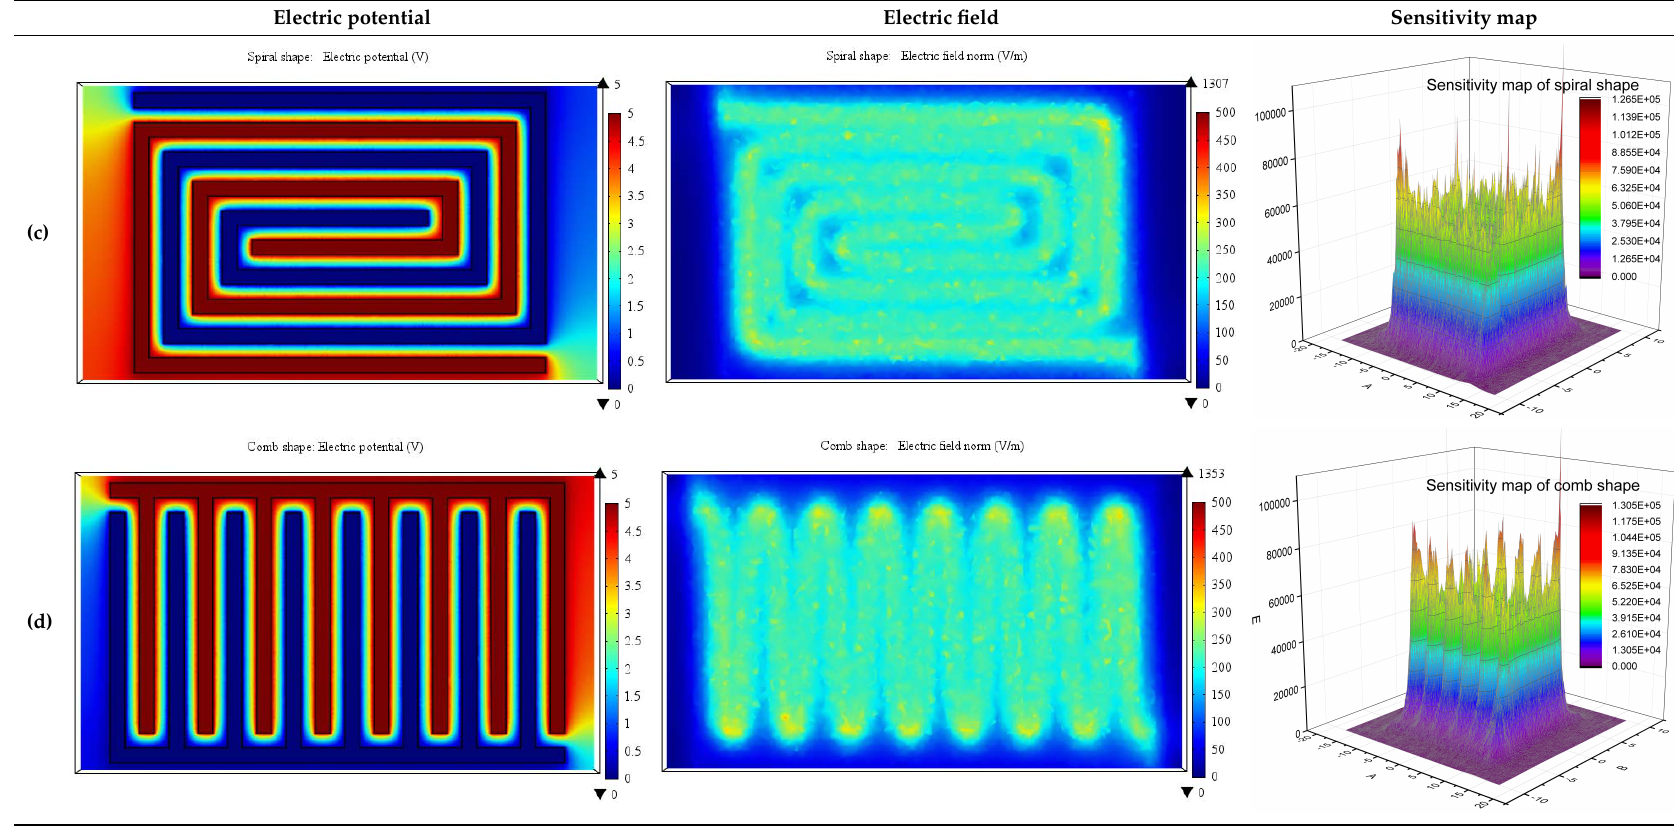
Figure 5. Simulated electric potentials, electric fields and sensitivity maps of four electrode shapes: ( a ) Circular shape; ( b ) Rectangular shape; ( c ) Spiral shape and ( d ) Comb